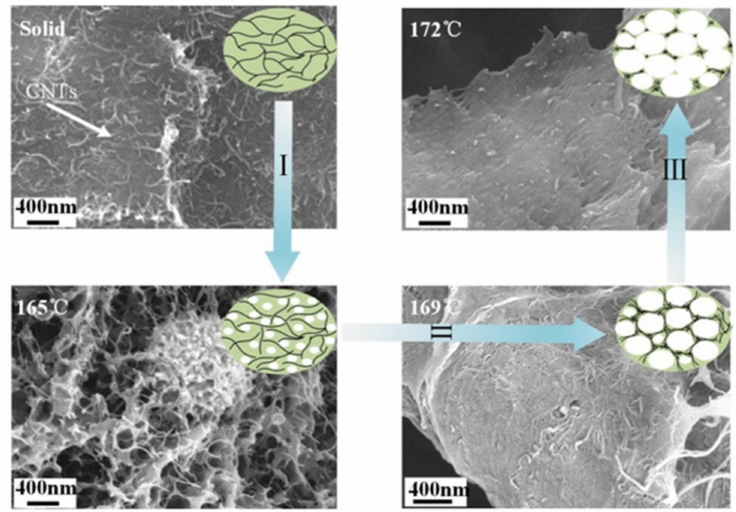
Figure 7. The SEM images of CNT distribution in solid, F-165, F-169, and F-172 samples; The inset in each image is a schematic diagram of the CNT